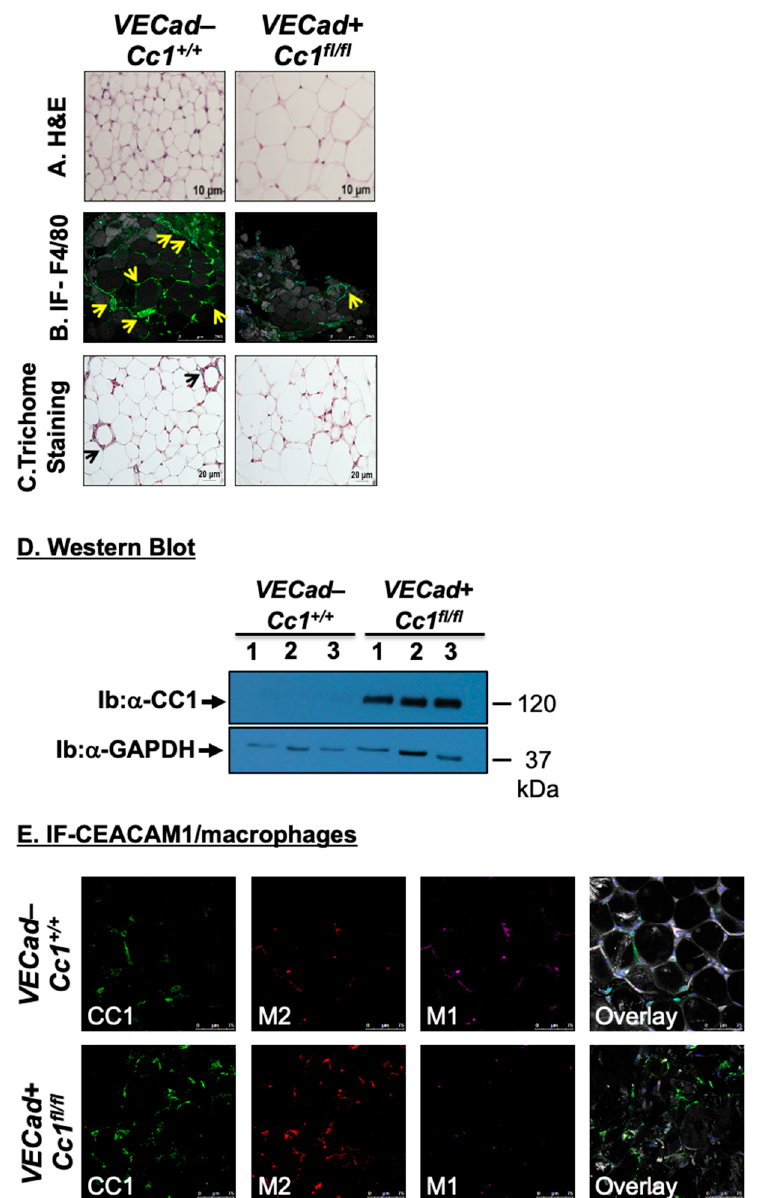
Figure 6. White adipose tissue histology and CEACAM1 expression. ( A ) White adipose tissue histology was assessed in H&E-stained sections ( n > 4 mice/genotype). It indicates adipocytes’ expansion in KO versus WT. Representative images from three sections per mouse are shown. Scale bar: 10µm. ( B ) Whole WAT was stained with BODIPY 558/568 to detect lipid (gray) and with anti-F4/80 to detect macrophages (green) and DAPI (blue) to detect nuclei. All images were captured using LSCM with a 20× objective and are 2D projections of a 3D image z-stack. Scale bar: 250µm. Yellow arrows show multiple areas with crown-like structures (CLS) containing macrophages